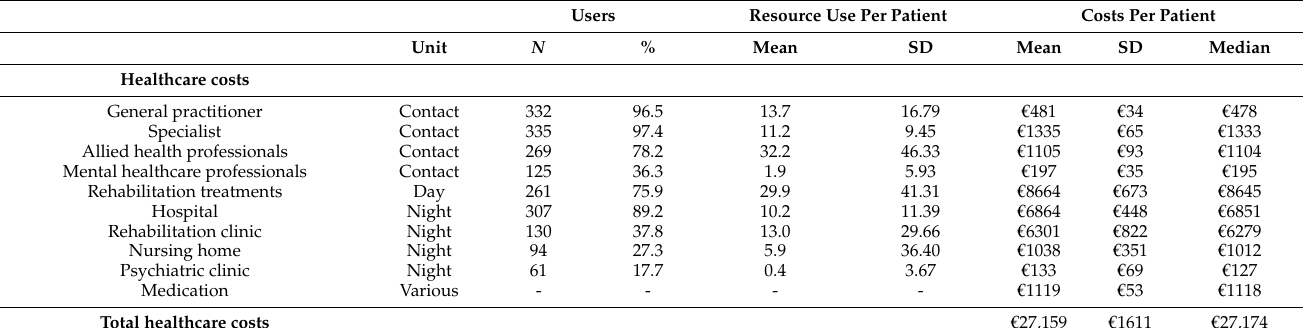
Table 2. Total resource use and costs (bootstrapped) in the first two years post-stroke ( n =